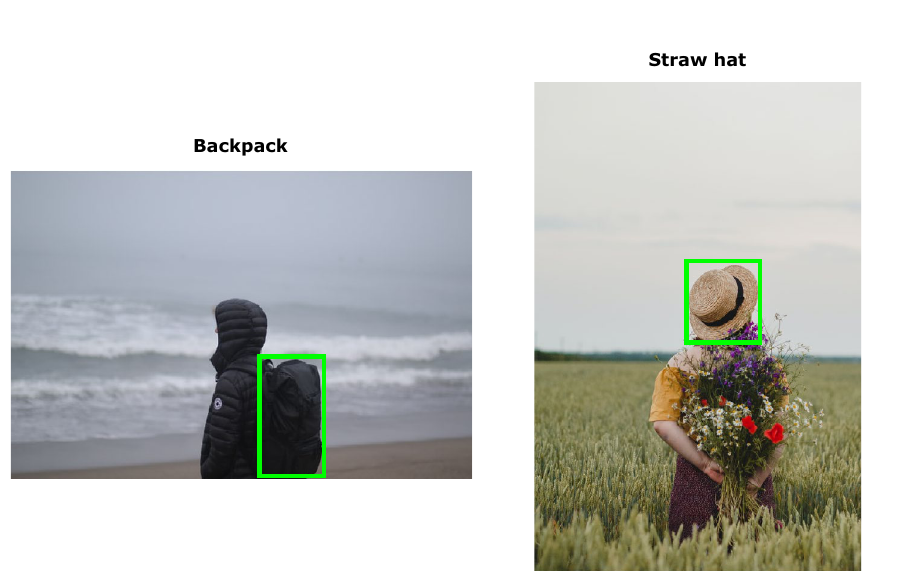
Figure 7. Item bounding-box detection. Localization maps can be easily extended to provide zero-shot bounding boxes for items of interest.Green bounding boxes show the predicted locations for fashion concepts “Backpack” (left) and “Straw hat” (right). Images above are taken from the publicly available Unsplash Lite Dataset 1.2.0: FashionCLIP was tested extensively on ModaNet - please reach out to authors for links to those images.